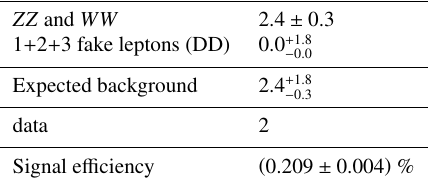
Table 1. Number of selected data events, expected number of background events ( ZZ and WZ events estimated from MC simu- lation samples and DD estimations for 1 and 2 + 3 fake leptons) and the estimated signal e ffi ciency (multiplied by the correspon- ding W - and Z -bosons’ BRs), after the final selection. The corres- ponding statistical uncertainties are also